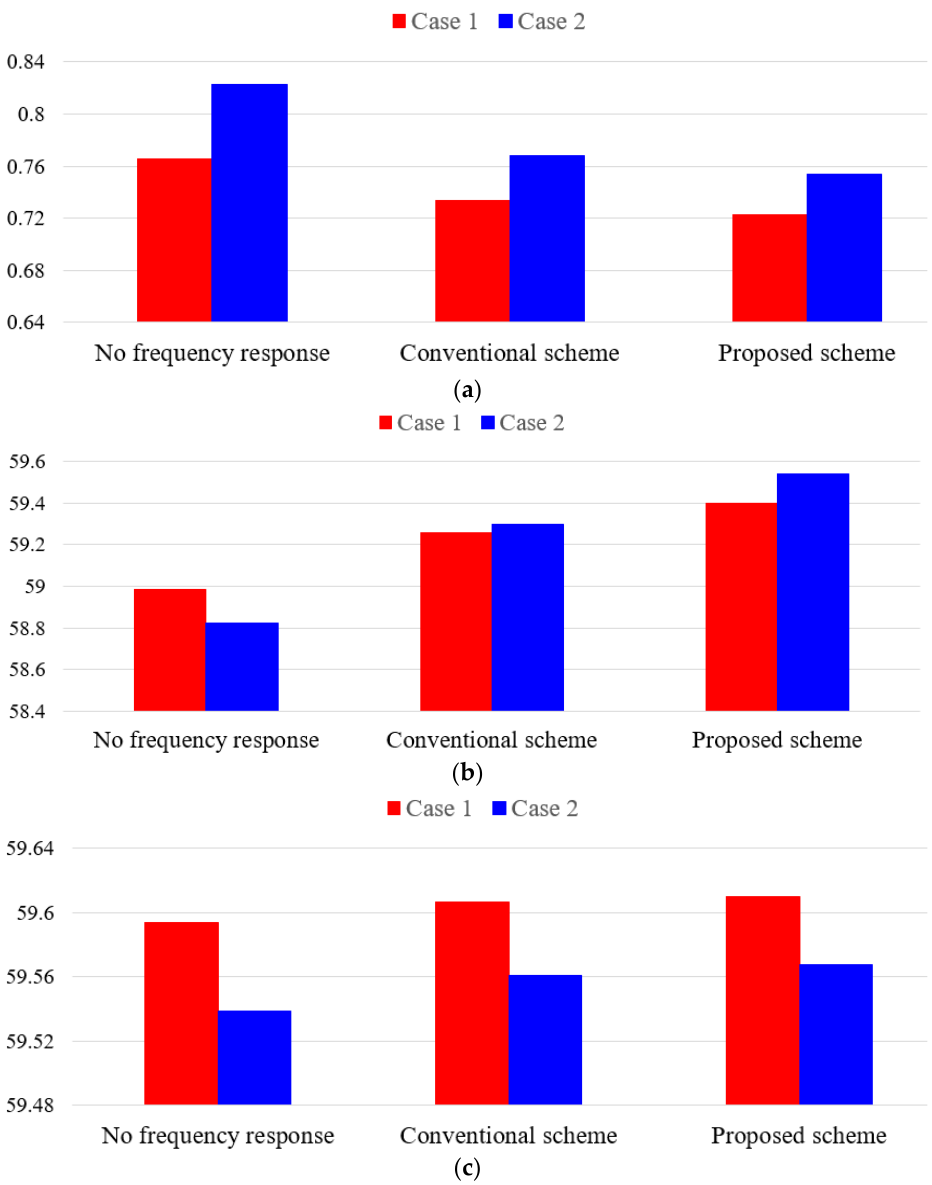
Figure 12. Comparison results for Case 1 and Case 2 : ( a ) maximum ROCOF; ( b ) frequency nadir; ( c ) Settling frequency.